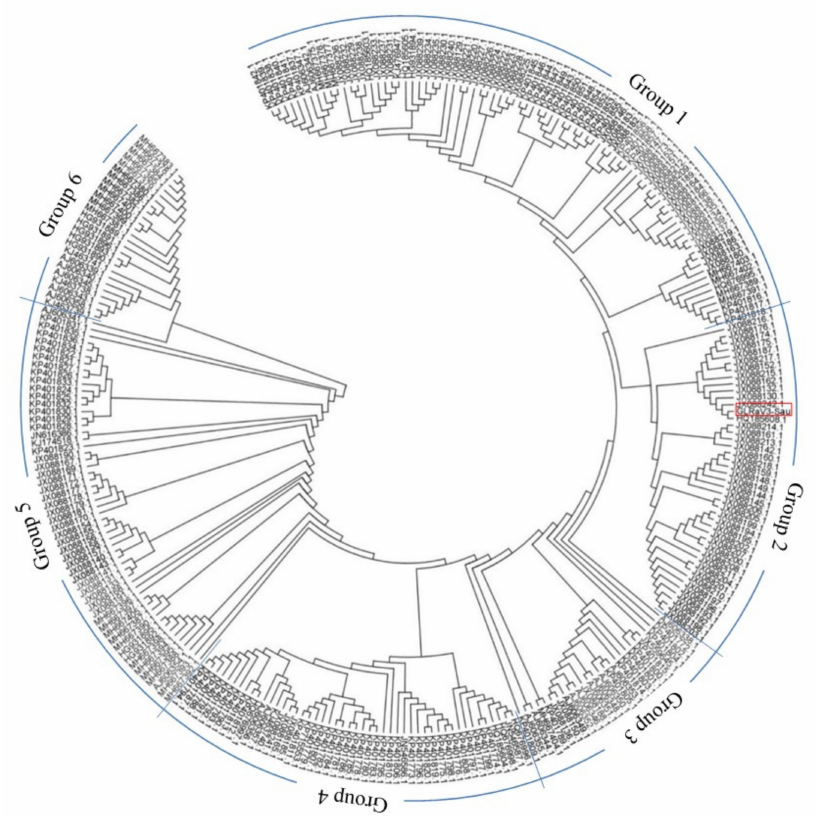
Figure 4. Unrooted phylogenetic tree, generated with CP nucleotide sequence of the isolate GLRaV3- Sau and other GLRaV-3 isolates available in GenBank. The red square denotes